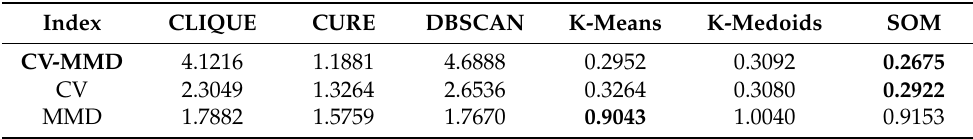
Table 3. summarizes the results evaluated by the CV-MMD index. Table 3. Evaluation results based on CV-MMD